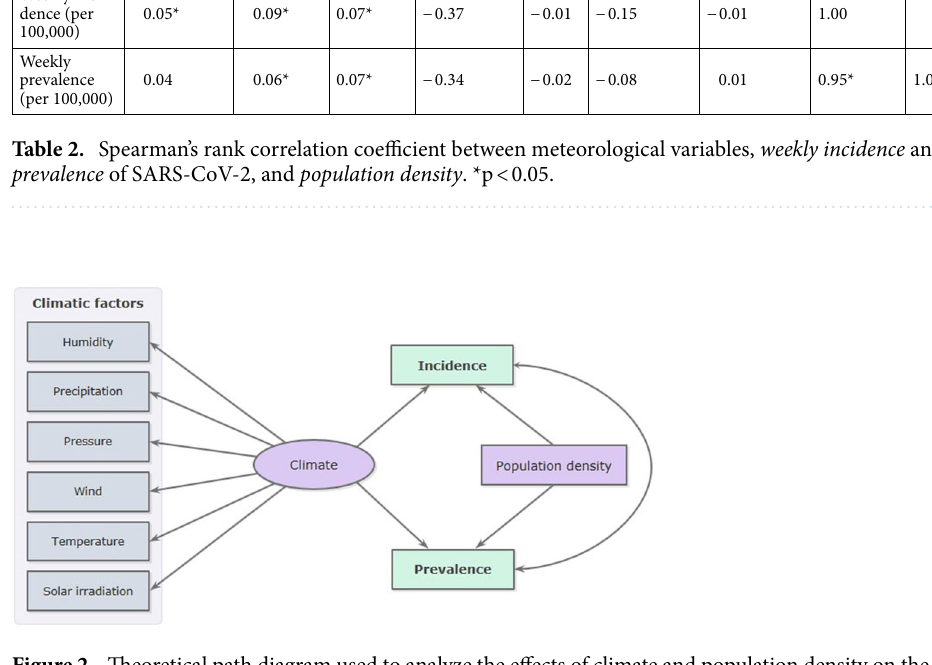
Figure 2. Theoretical path diagram used to analyze the effects of climate and population density on the spread of SARS-CoV-2. This diagram was generated using Office Power Point software, version 2010 (https:// www. micro soft. com/ it- it/ micro soft- 365/ power